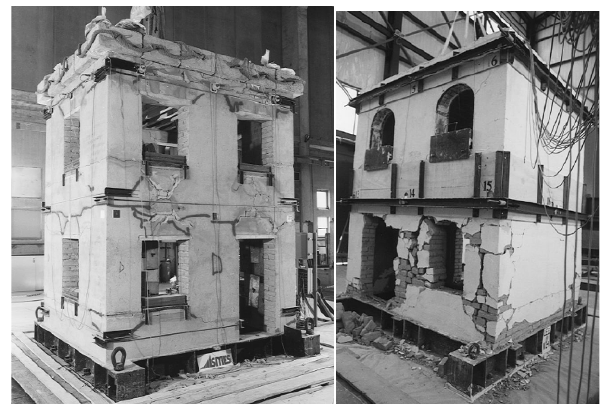
Fig. 22 Post tensioning application on masonry specimens by Benedetti et al., . (1998) Fig. 22. Post tensioning application on masonry specimens by Benedetti et al. (1998).